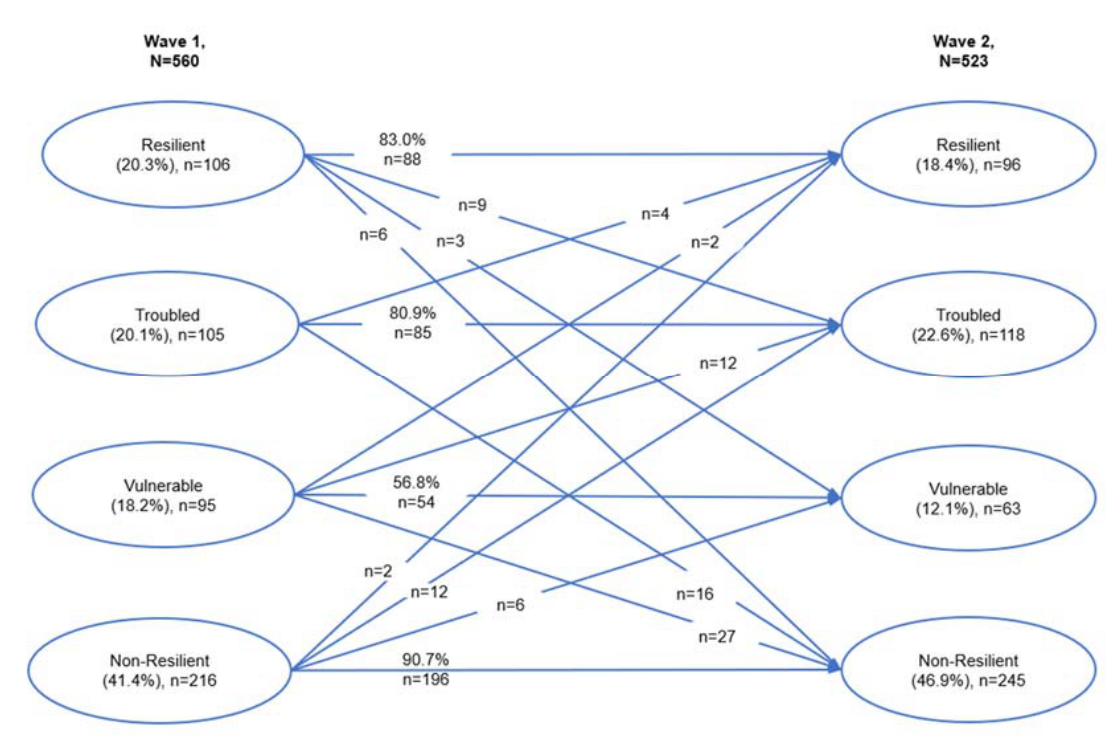
Figure 2. Classes transition over time.